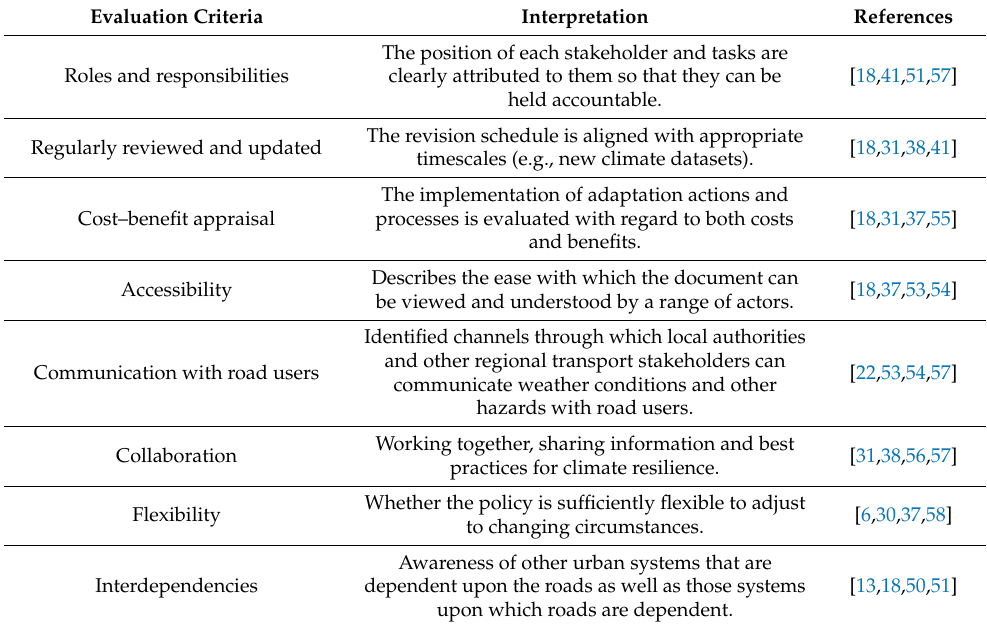
Table 2. Evaluation criteria for comparing resilient infrastructure